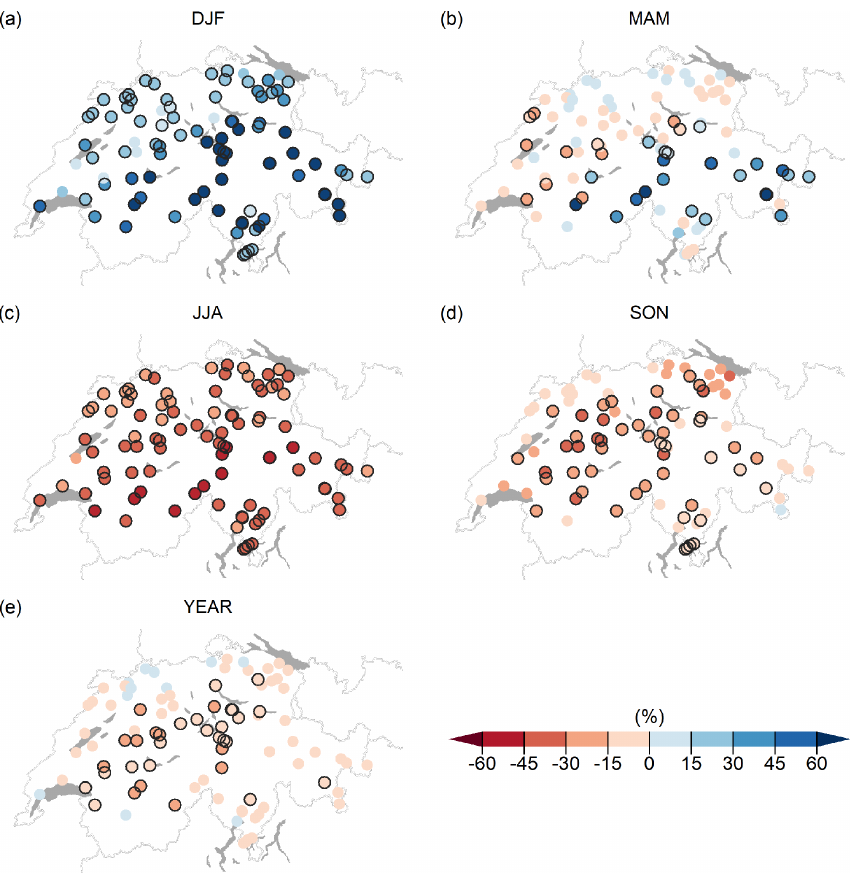
Figure 2. Multimodel median of seasonal and annual mean changes of runoff under RCP8.5 by 2070–2099 for winter (a) , spring (b) , summer (c) , autumn (d) , and annual means (e) . Black circles indicate catchments whose direction of change agrees across at least 90% of the